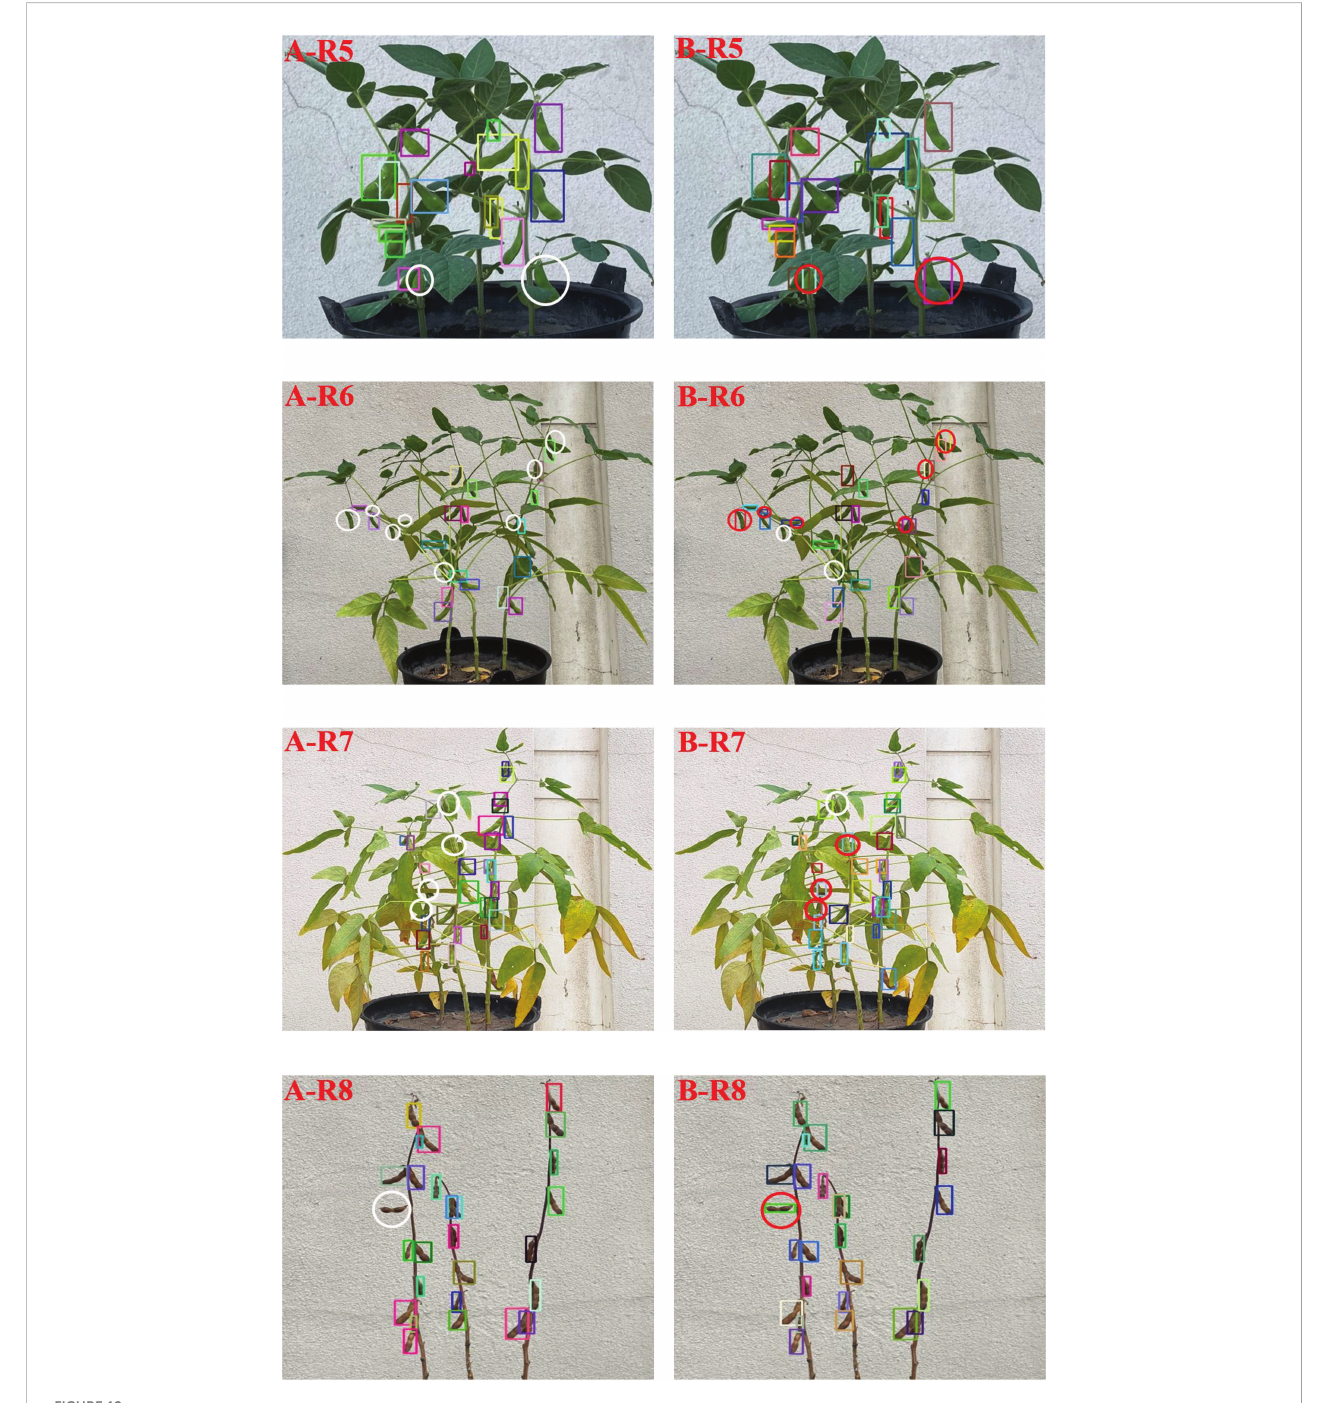
FIGURE 12 Comparison of partial recognition results before and after model improvement (A) YOLOv5 model; (B) Improved YOLOv5